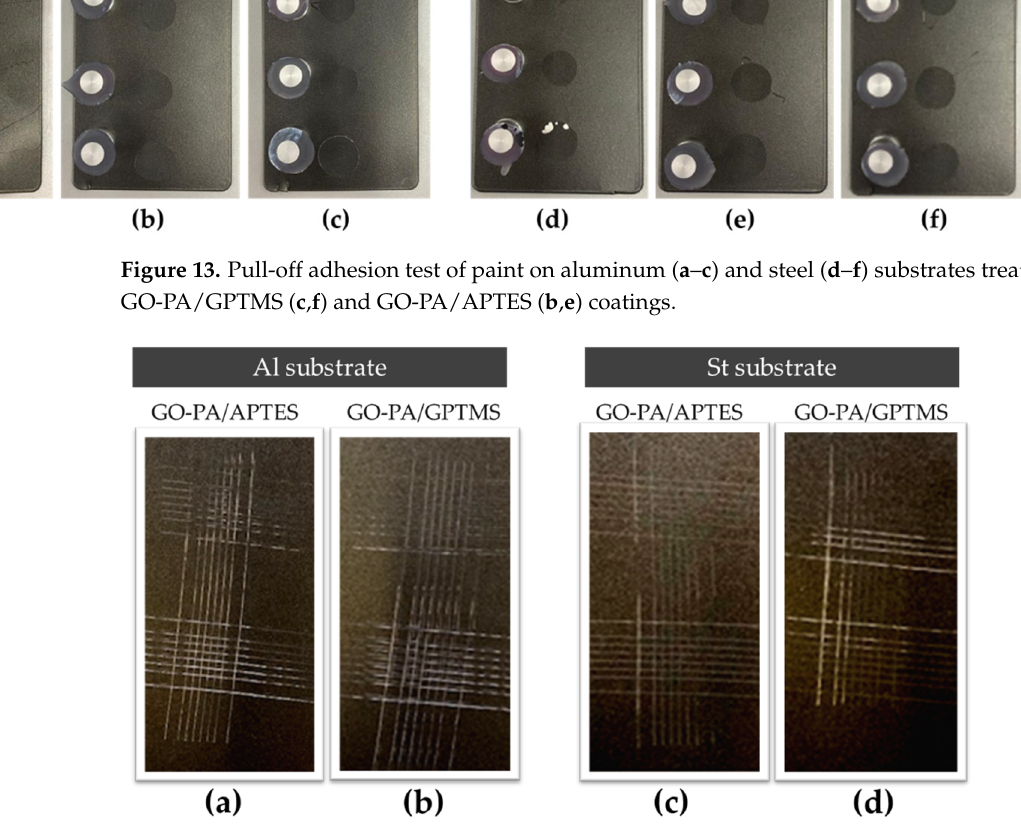
Figure 14. Adhesion cross-cut test of paint on aluminum ( a , b ) and steel ( c , d ) substrates treated with GO-PA/GPTMS ( b , d ) and GO-PA/APTES ( a , c ) coatings.